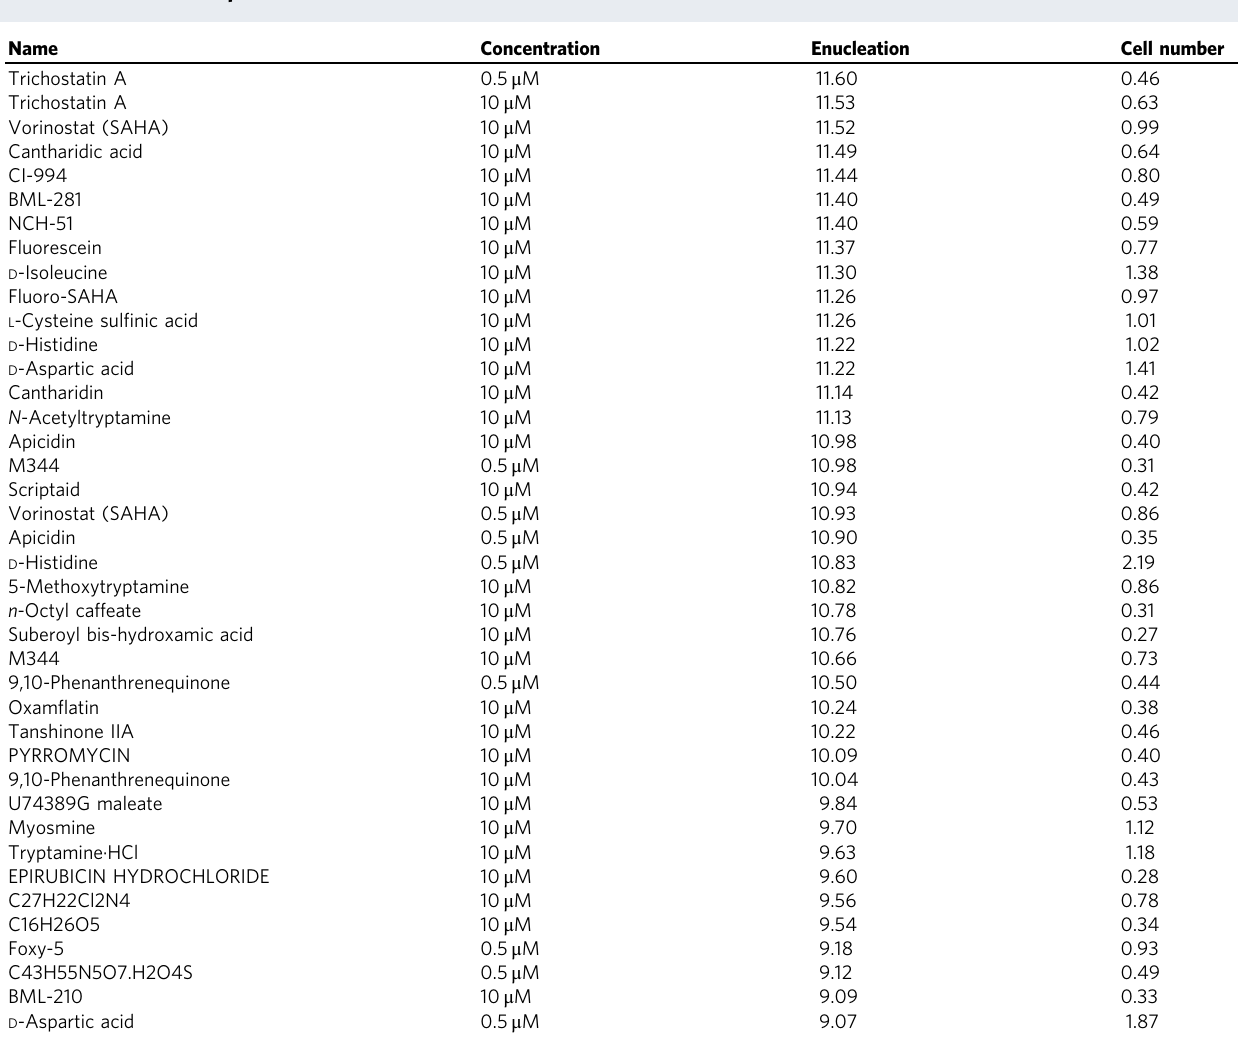
Table 1 List of hit compounds.